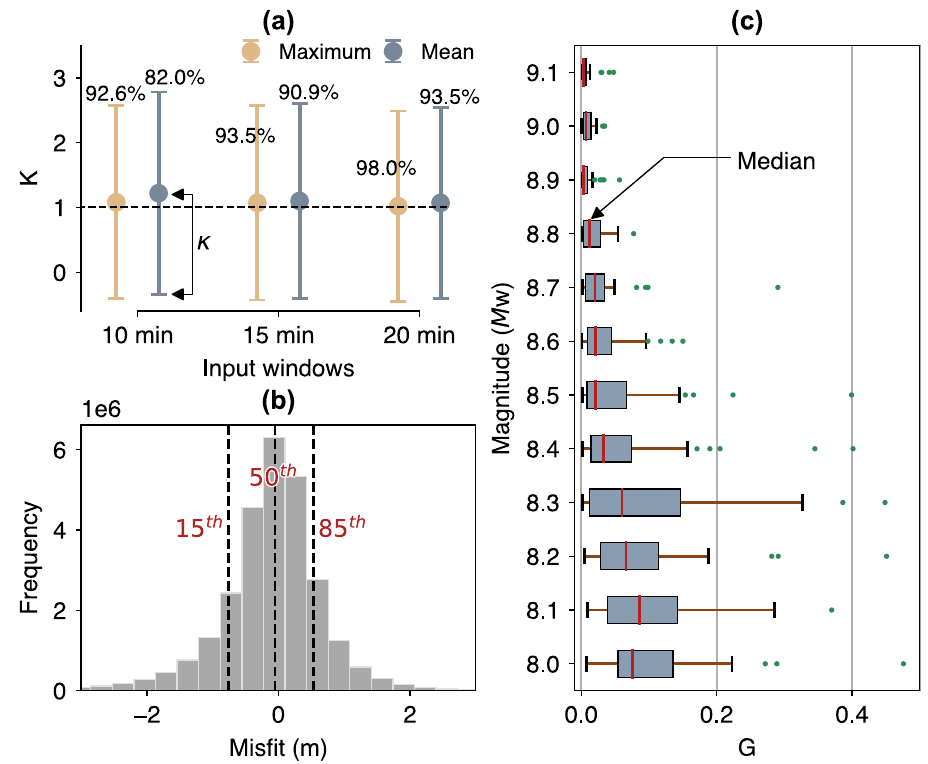
Fig. 4 | Statistical evaluations of the test set. a Aida ’ s numbers ( K and κ ) and accuracymeasurein percentage using maximum and meantsunami amplitudes as inputs at three prediction time windows of 10, 15, and 20min. b Distribution of mis fi ts with 15th, 50th, and 85th percentiles (dashed lines). c Box plot of the